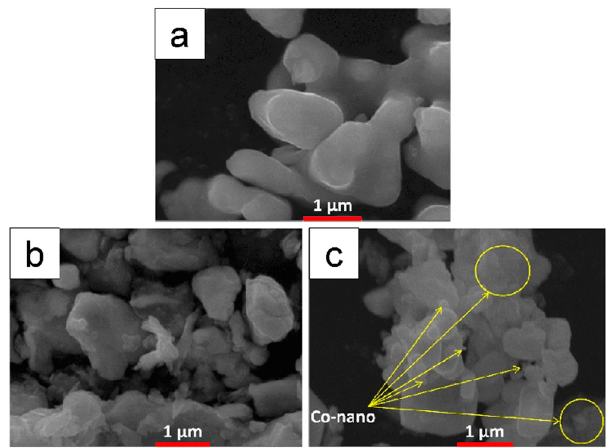
Figure 5. The SEM micrographs of three sets of Co micropowders: ( a ) untreated Co powder, ( b ) HEMT treated Co powder, ( c ) nanomodification, and HEMT treatments on Co powders.